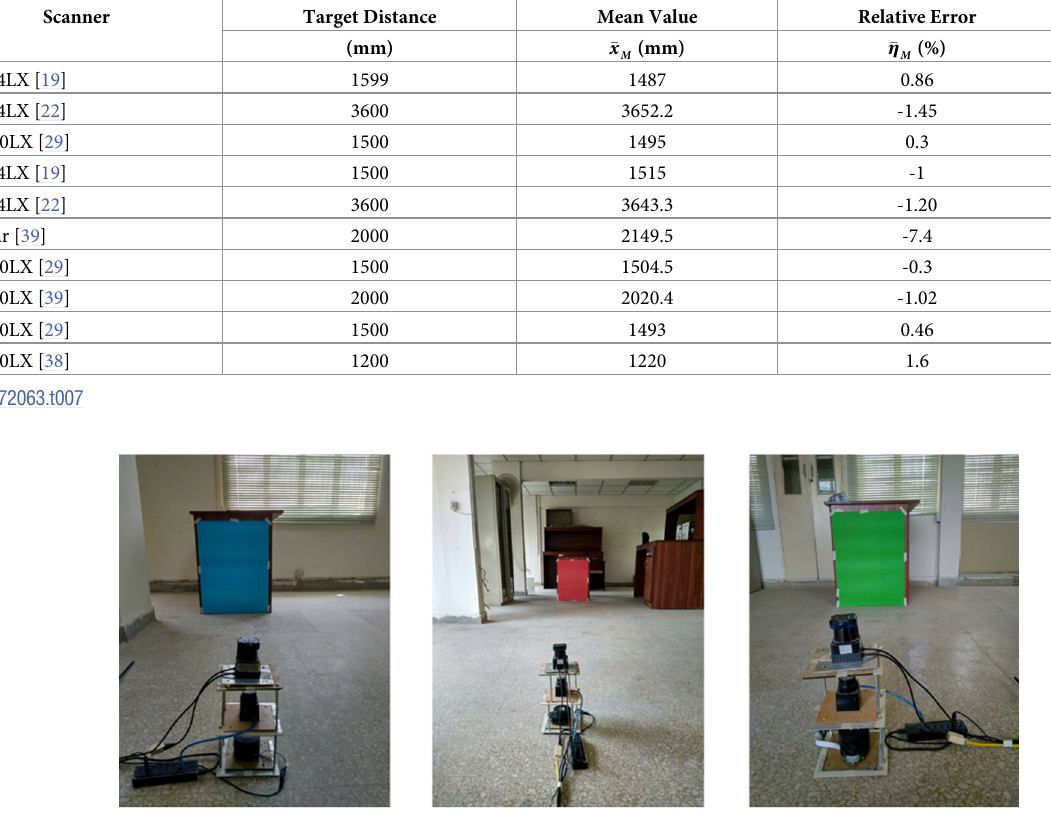
Fig 19. Indoor experimental setup for color test, (left) Blue (middle) Red (right) Green colored objects.